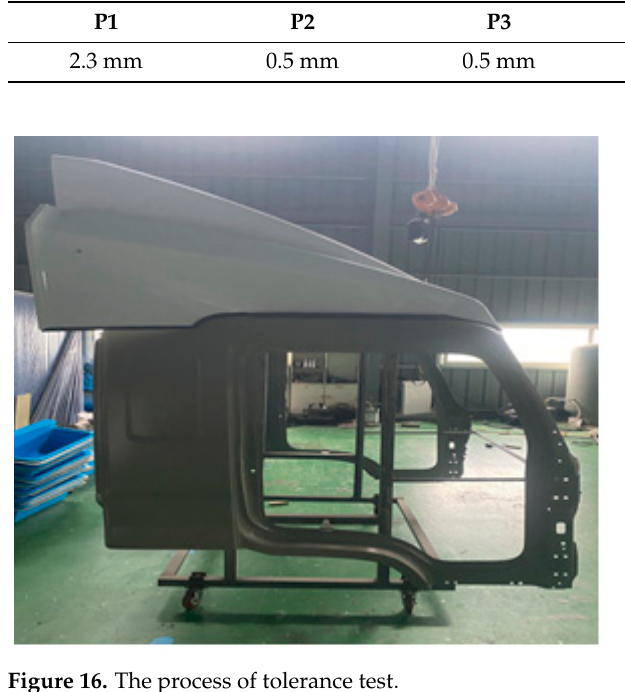
Table 8. Tolerance test.